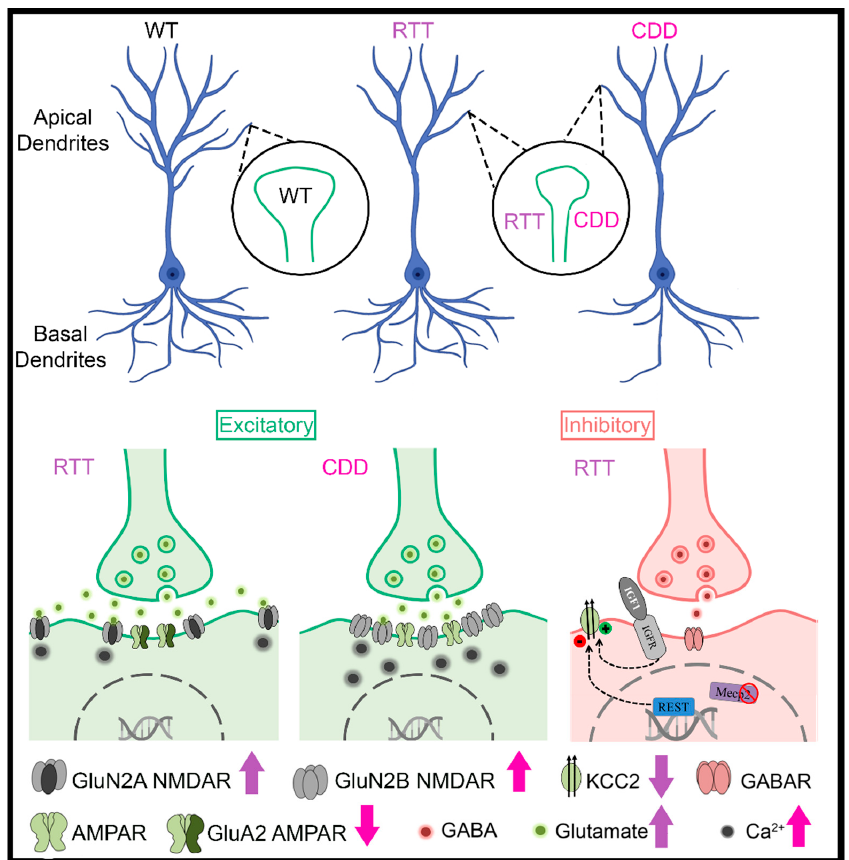
Figure 1. Alterations in dendrites, spines, glutamatergic neurotransmission, and GABAergic neurotransmission are observed in Rett syndrome (RTT) and CDKL5 disorder (CDD) (Schematic generated with the help of Biorender). Arrows indicate deviations from wild-type (WT) controls. (Blue et al., 1999, 2011 [28,29]; Durand et al., 2012 [30]; Johnston et al., 2014 [31]; Lo et al., 2016 [32]; Banerjee et al., 2016 [33]; Della Sala et al., 2016 [24]; Tang et al., 2016, 2019 [34,35]; Okuda et al., 2017 [36]; Tramarin et al., 2018 [37]; Dong et al., 2018 [38]; Zhu and Xiong, 2019 [22]; Ren et al., 2019 [23]; Yennawar et al., 2019 [39]).